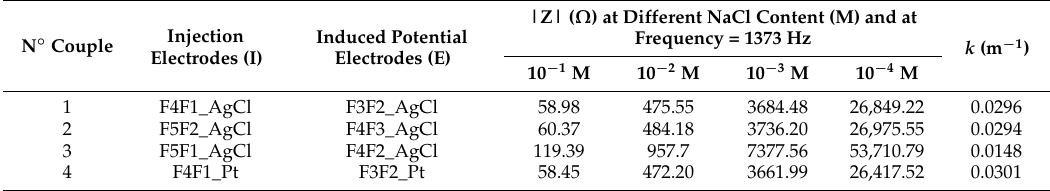
Table 5. Summary of the impedance measures realized on the different electrodes couples for the determination of the geometric factors. An AC of 10 µA at a frequency of 1373 Hz has been applied during these experiments.